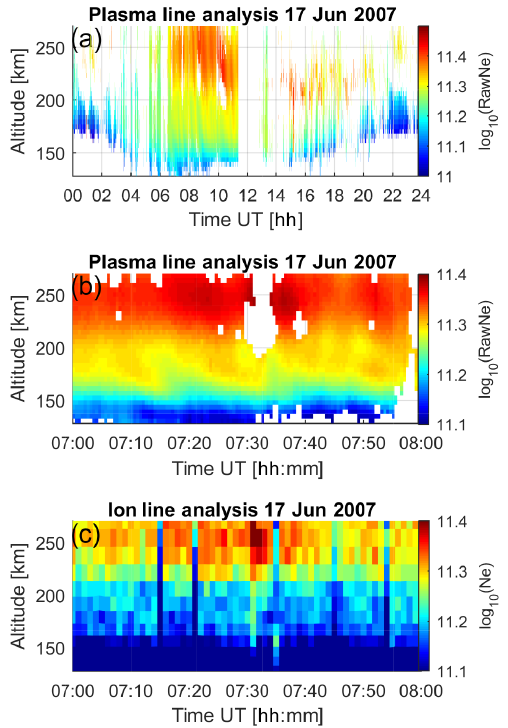
Figure 3. Electron density on 17 June 2007. Panels (a) and (b) show electron density recovered from 30s integrated plasma line data. Panel (c) shows electron density resulting from ion line analysis with 60s integration, performed with the GUISDAP tool (Lehtinen and Huuskonen, 1996).